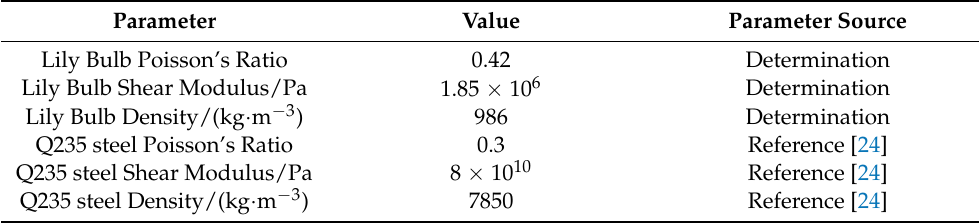
Table 2. Simulation test parameters.